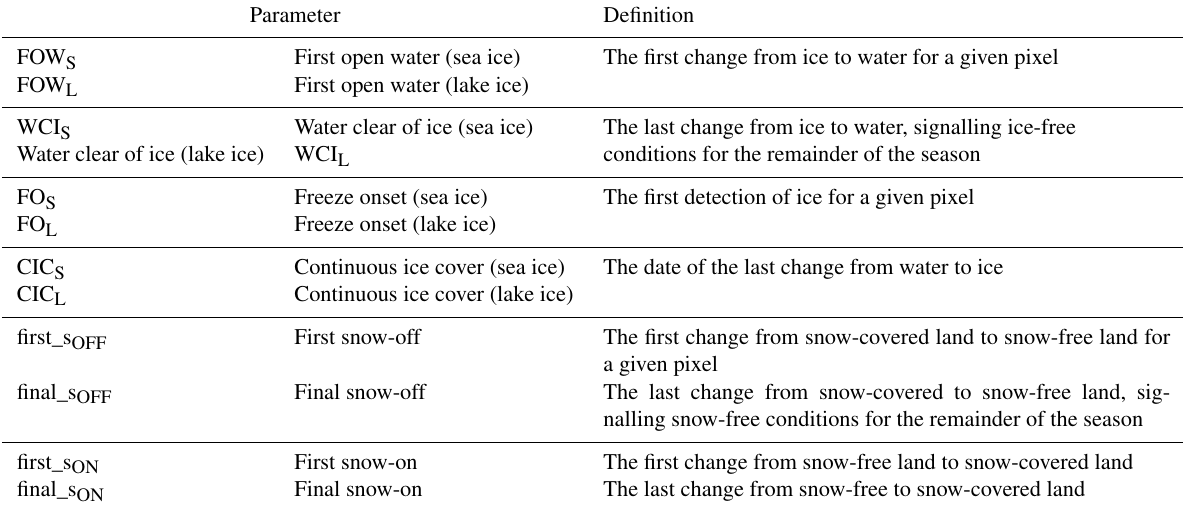
Table 1. Sea ice, lake ice, and snow phenology parameters and definitions in this study. Parameter Definition First open water (sea ice) The first change from ice to water for a given